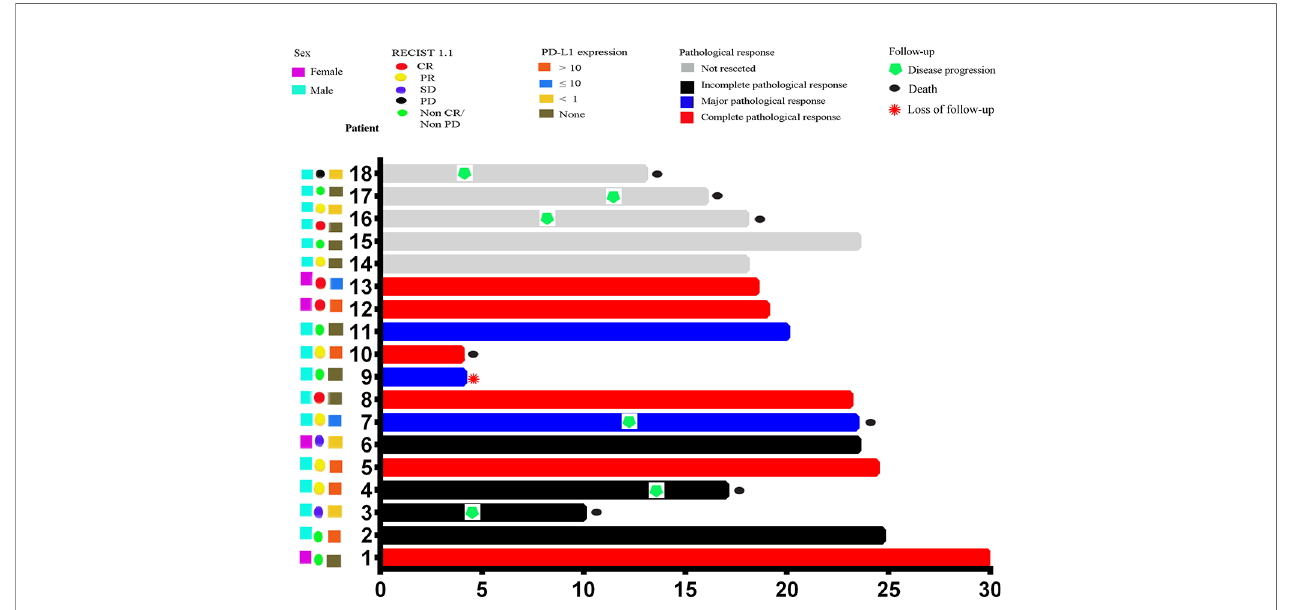
FIGURE 2 | Swimmer plot of PFS in the modi fi ed intention-to-treat population (n = 18). Each bar represents one patient. The left column shows clinical characteristics. PFS, progression-free